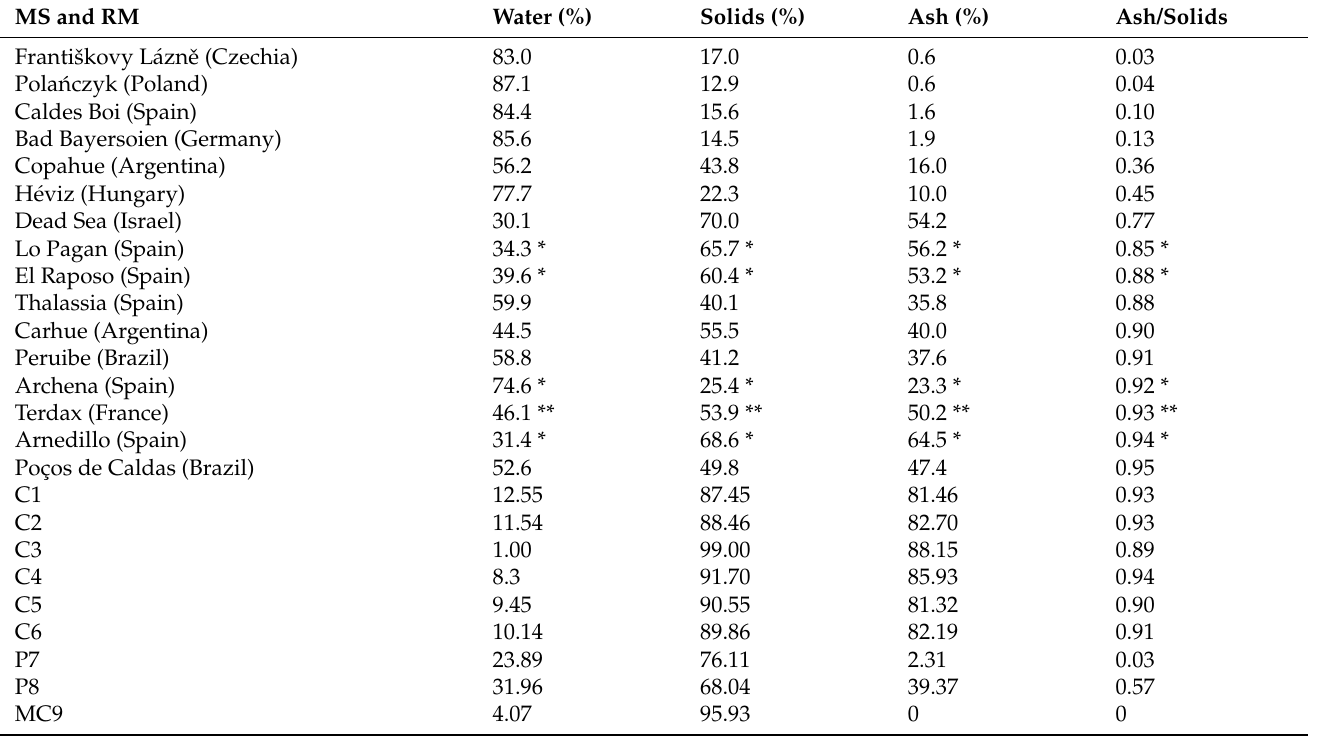
Table 2. Centesimal composition of peloids used in medical spas (MSs) and raw materials (RMs).